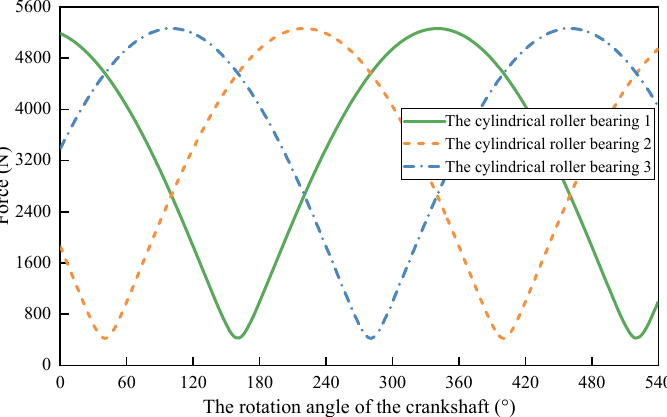
Figure 7. The variation of forces acting on the cylindrical roller bearings.